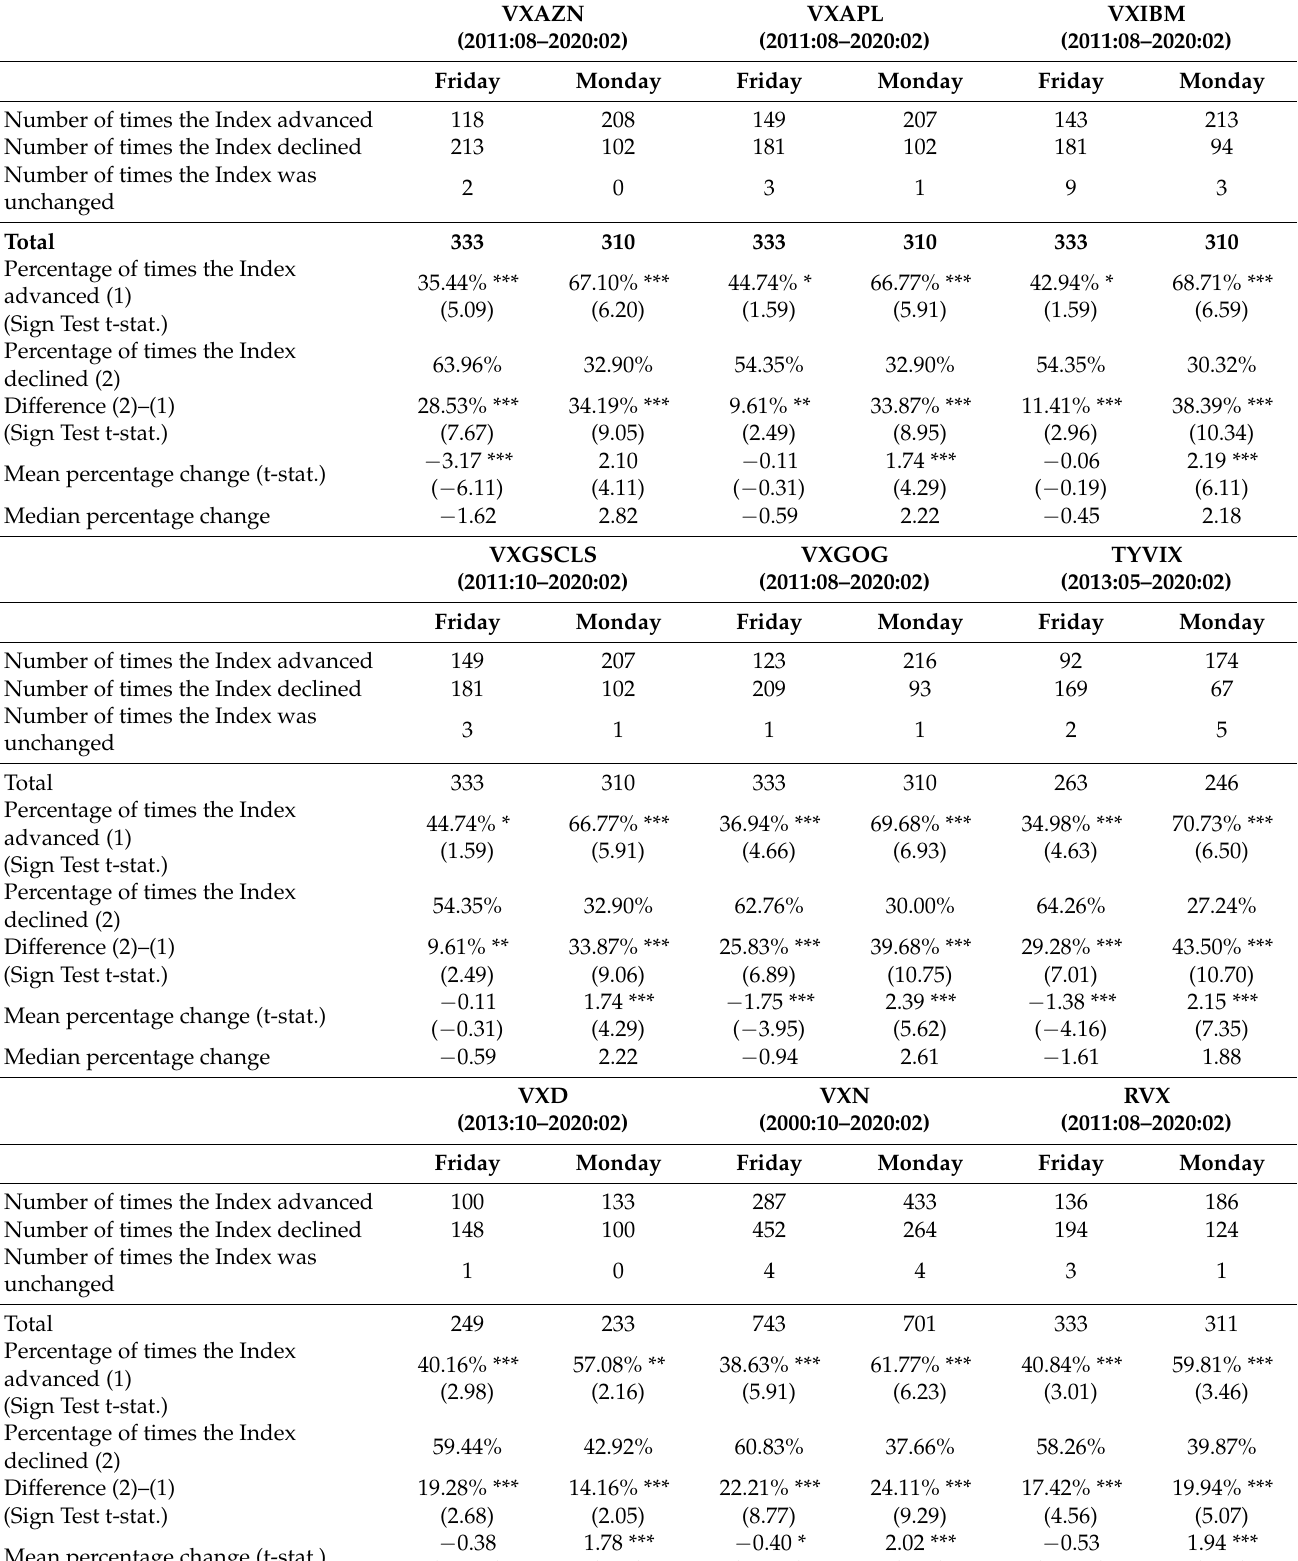
Table 4. Sign directions of Fridays and Mondays after excluding the week on which options